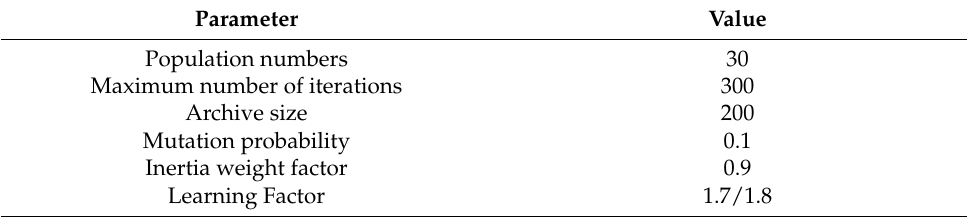
Figure 9. The effect of the archive size on the optimization results: ( a – d ) Archive sizes were 20, 200, 300, and 500, respectively. Table 3. Optimized model parameter settings.